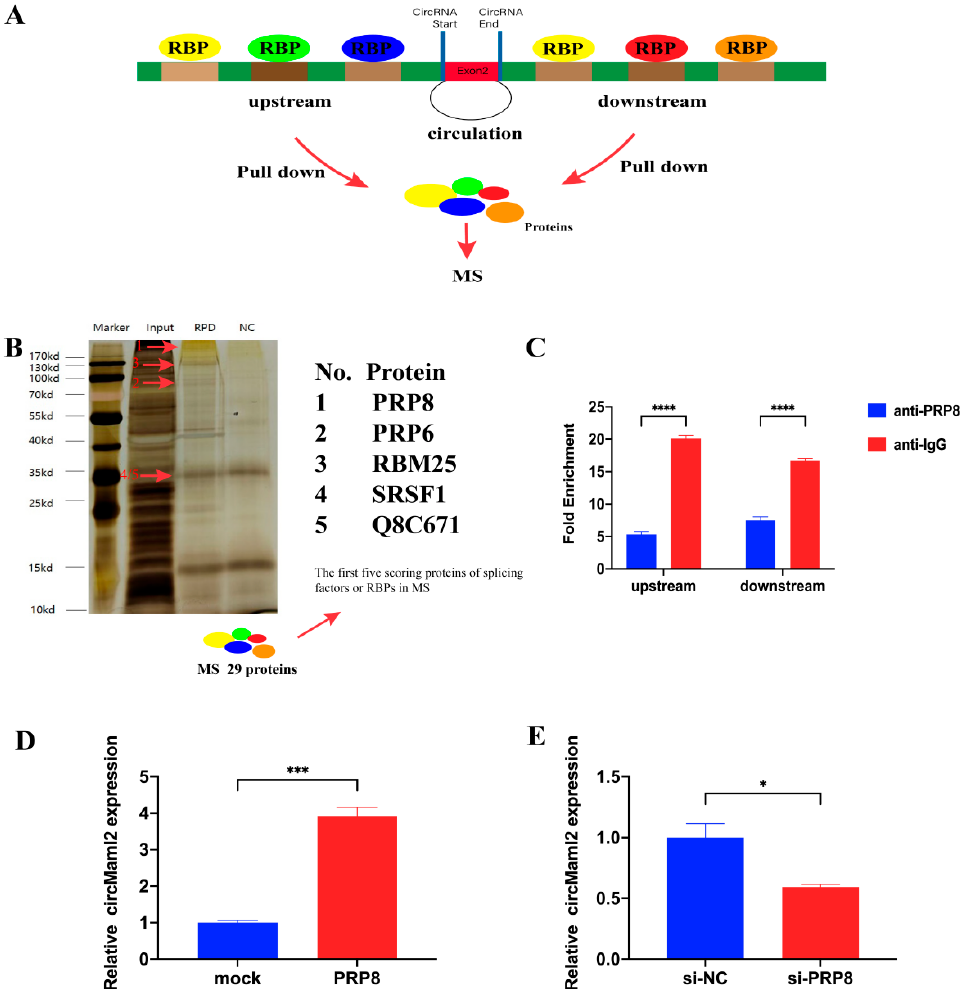
Figure 7. PRP8 Induces the Biogenesis of CircMaml2. ( A ) Schematic diagram of pull-down and MS and proteins in the upstream and downstream region that interact with circMaml2 pre-mRNA. ( B ) Identification of associated proteins that interact with circMaml2 pre-mRNA by silver staining and MS. ( C ) RIP assay confirmed that PRP8 could directly bind to the Maml2 pre-mRNA in MC38 cells (**** p < 0.0001, two-way ANOVA). ( D , E ) circMaml2 expression was detected in MC38 cells after PRP8 up-regulation or down-regulation by qRT-PCR (* p = 0.0264, *** p = 0.0003, t test). All data are presented as mean + SEM. ns, not significant. n = 3.